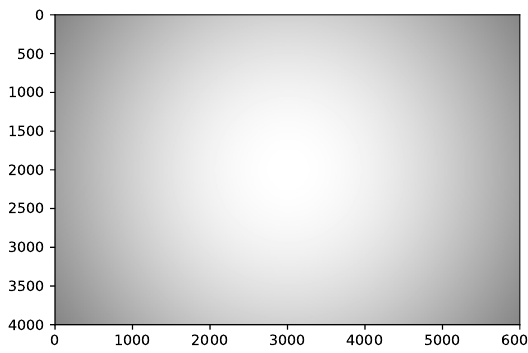
Fig. 12.— Flatfield image taken with the same telescope- instrument combination as the holiday snap, with clearly visible